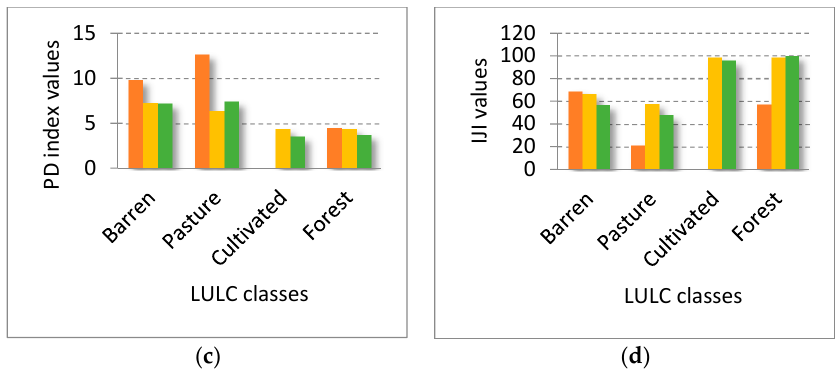
Figure 7. Landscape metrics at class level for HSCZ 1984, 19988, and 2015: ( a ) class area; ( b ) largest patch index and ( c ) patch density; and ( d ) interspersion and juxtaposition.